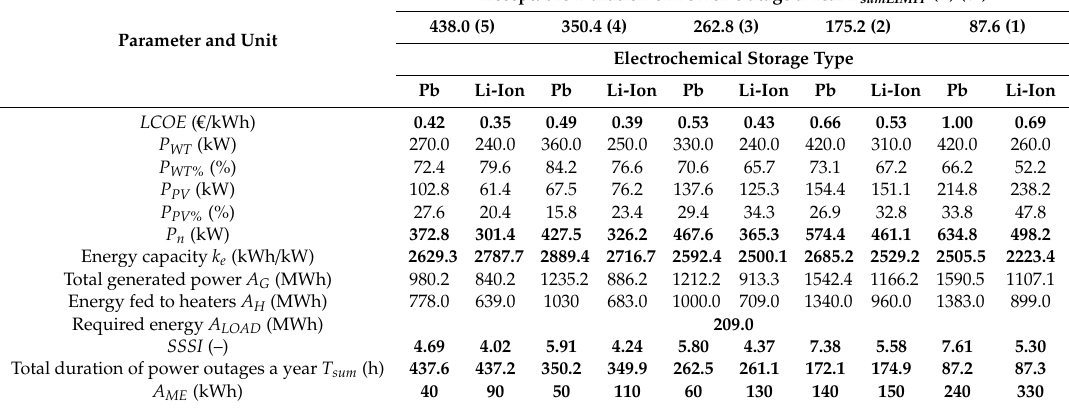
Table 4. Results of PV-wind hybrid power supply system structure optimization (lead-acid and lithium-ion battery) for a 50 kW peak power of an industrial communal load with no limit for